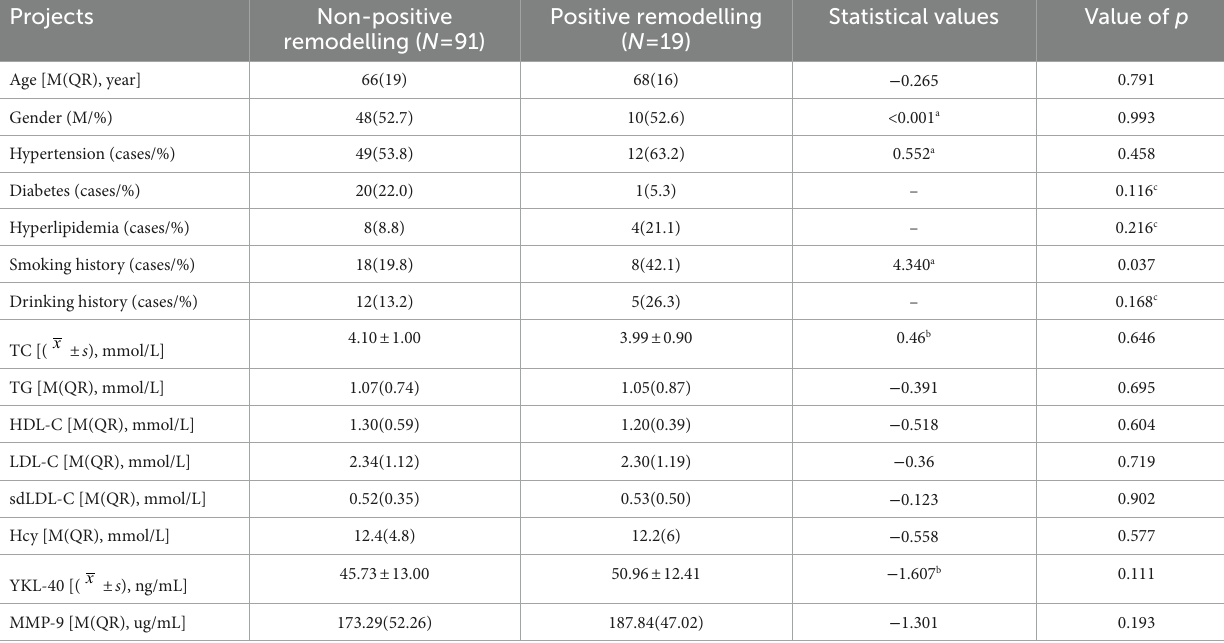
TABLE 3 Comparison of positive and non-positive remodelling in anterior